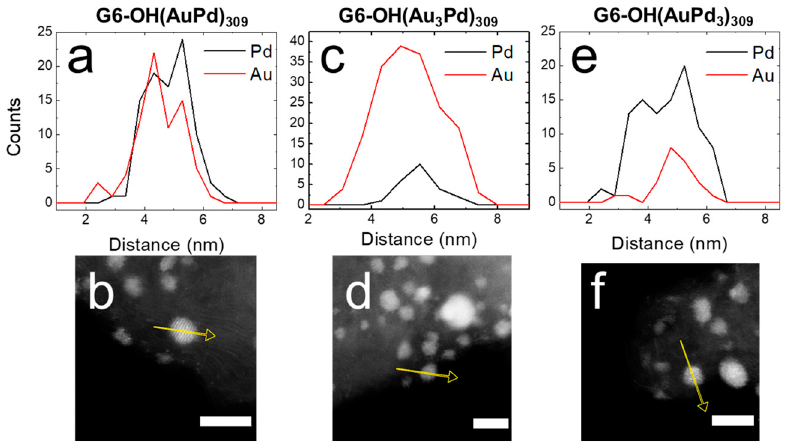
Figure 2. EDS line scans and corresponding ac-STEM micrographs for conductive inks containing as-prepared ( a , b ) G6-OH(AuPd) 309 ; ( c , d ) G6-OH(Au 3 Pd) 309 ; and ( e , f ) G6-OH(AuPd 3 ) 309 DENs. The yellow arrow on each ac-STEM micrograph corresponds to the x-axis of the EDS line scan. The scale bar is 5.0 nm.